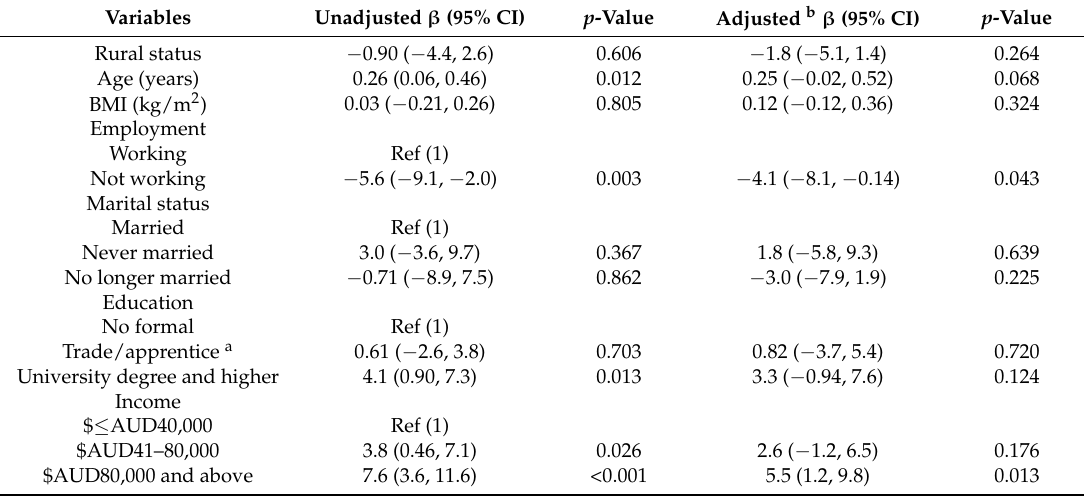
Table 5. Contributors of baseline demographic and anthropometric factors to total diet quality for urban and rural